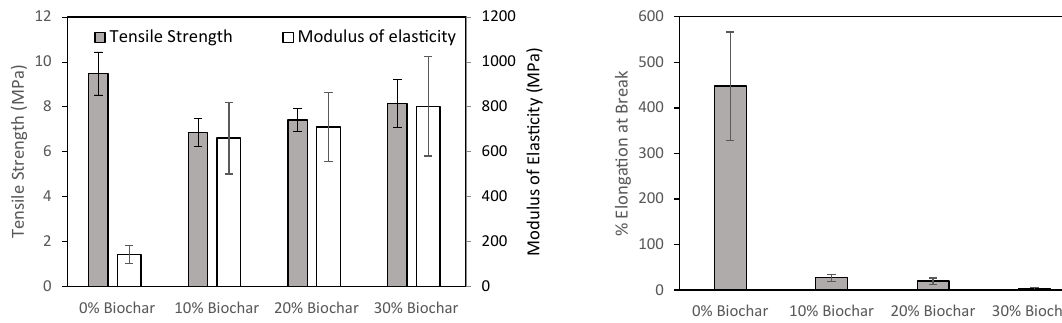
Figure 3. E ff ect of biochar content in 50:50 PCL:starch blend on ( a ) tensile strength and modulus of elasticity and ( b ) percentage of elongation at break.